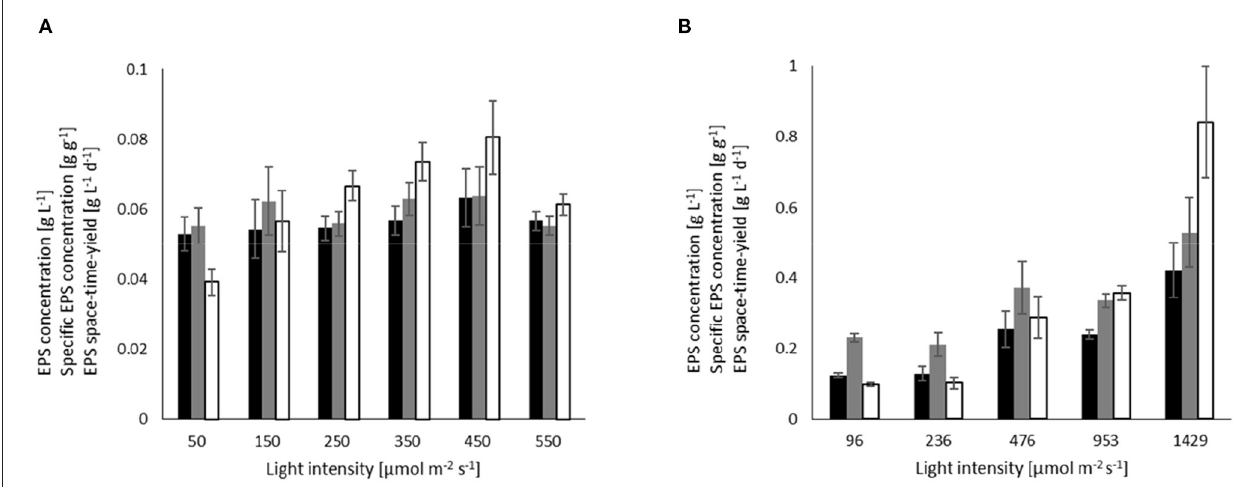
FIGURE 4 | Influence of light on the EPS concentration (black), EPS yield (gray), and space-time yield (white) in turbidostat processes at a biomass concentration of 1g L − 1 for (A) A. platensis cultivated at 35 ◦ C, and (B) C. asymmetrica cultivated at 30 ◦ C.